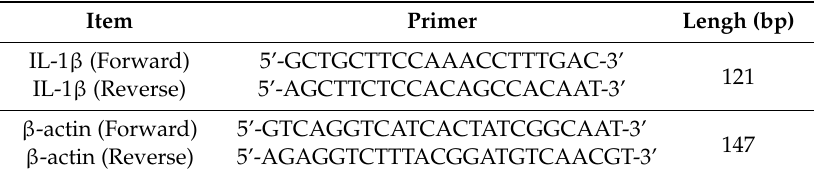
Table 1. Primer sequences for PCR amplification of IL-1 β and β -actin.